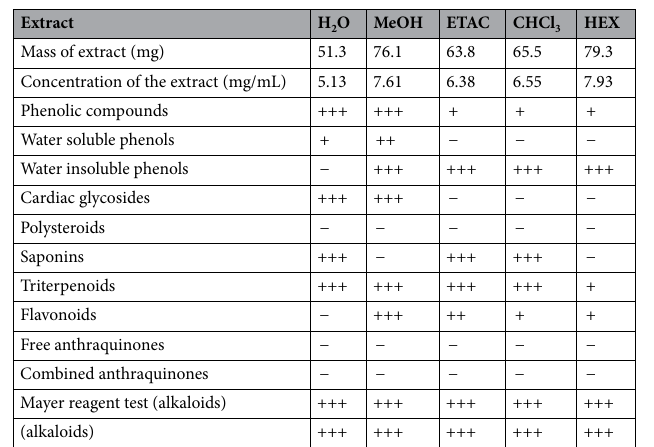
Table 1. Qualitative phytochemical screenings of T. impetiginosa bark extracts. H 2 O water extract, MeOH methanol extract, ETAC ethyl acetate extract, CHCl 3 chloroform extract, HEX hexane extract. +++ indicates a strong response; + + indicates a moderate response; + indicates a minor response; − indicates no response in the assay.